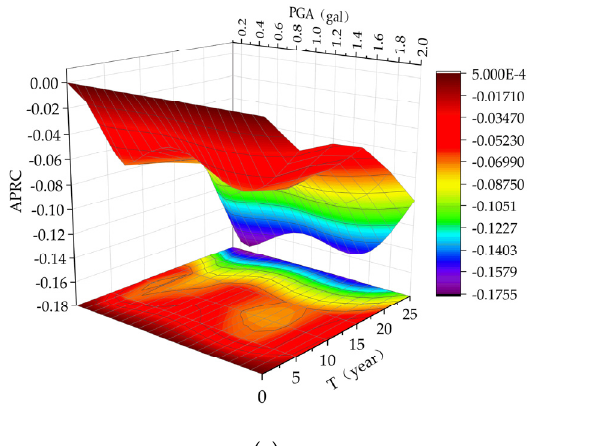
Figure 14. The Nihonkai-Chubu earthquake: ( a ) structural APRC value; ( b ) maximum Mises stress.